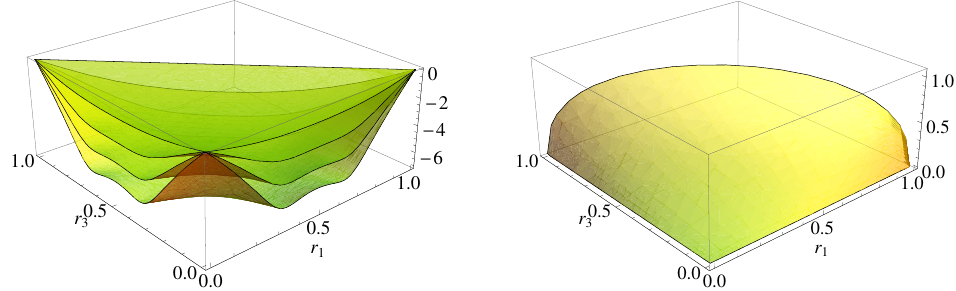
Figure 2 . Left: The function (2.6) for n (cid:16) 2 ; 4 ; 6 and 8 and k (cid:16) 2. Right: The function (2.8). Again, there is a change of curvature and sign when taking the limit n (cid:209) 1. Recall that 0 ⁄ r 1 (cid:0) r 3 ⁄ 1, which restricts the domain of de(cid:12)nition of the functions shown. A cross section of these surfaces is provided in (cid:12)gure 4